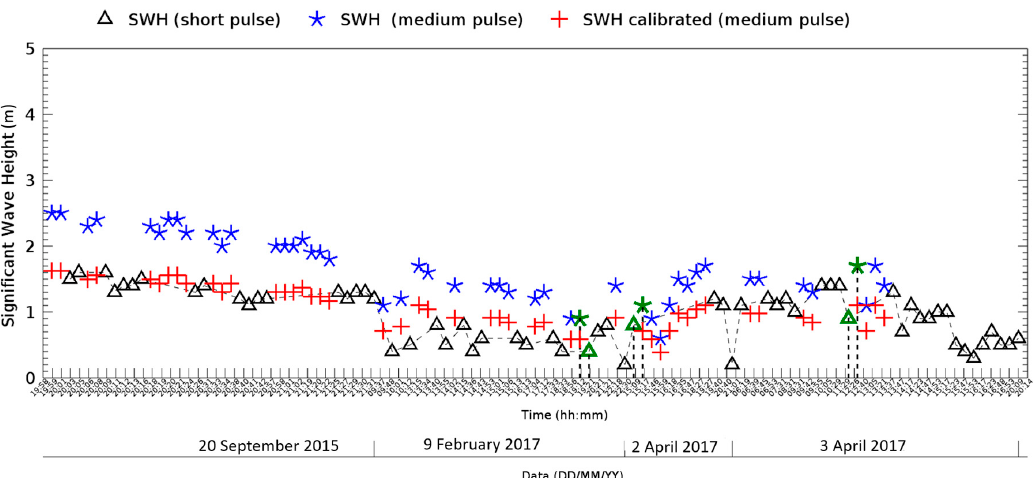
Figure 10. Significant wave height of dominant waves obtained by analyzing radar data in medium (blue star) and short (black triangle) pulse mode configurations. Red symbols refer to the medium pulse data after the application of the calibration factor. The green symbols and the vertical dashed lines indicate the measurements values obtained from the 3D wave spectra used for the qualitative comparison.